Question: Name the type of graph shown.
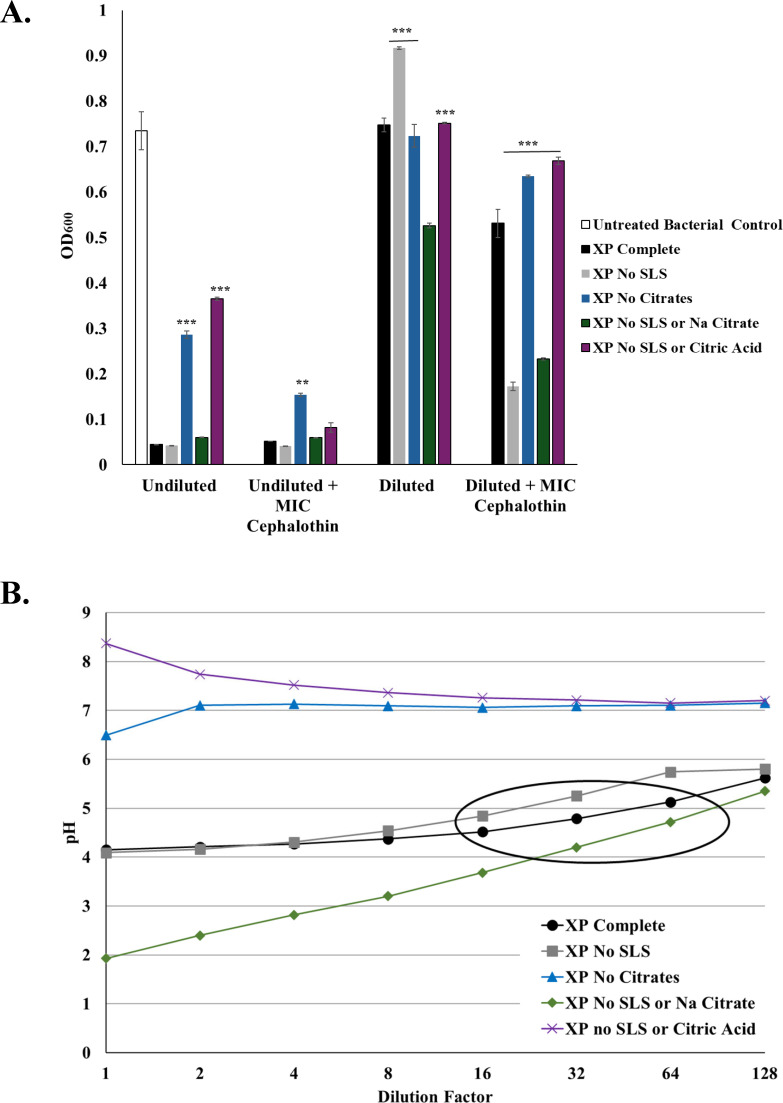
Answer: bar